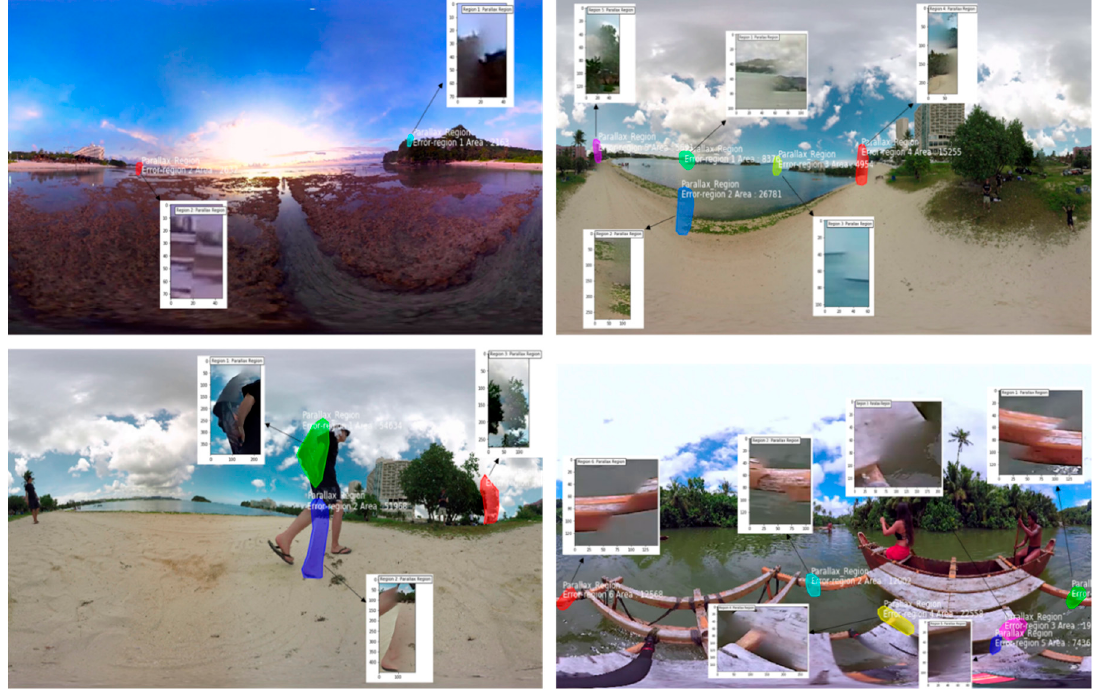
Figure 9. Extraction and visual inspection of segmented distorted regions in panoramic images. Table 2. The quantitative results obtained for distorted stitched patches and distorted panoramic images.